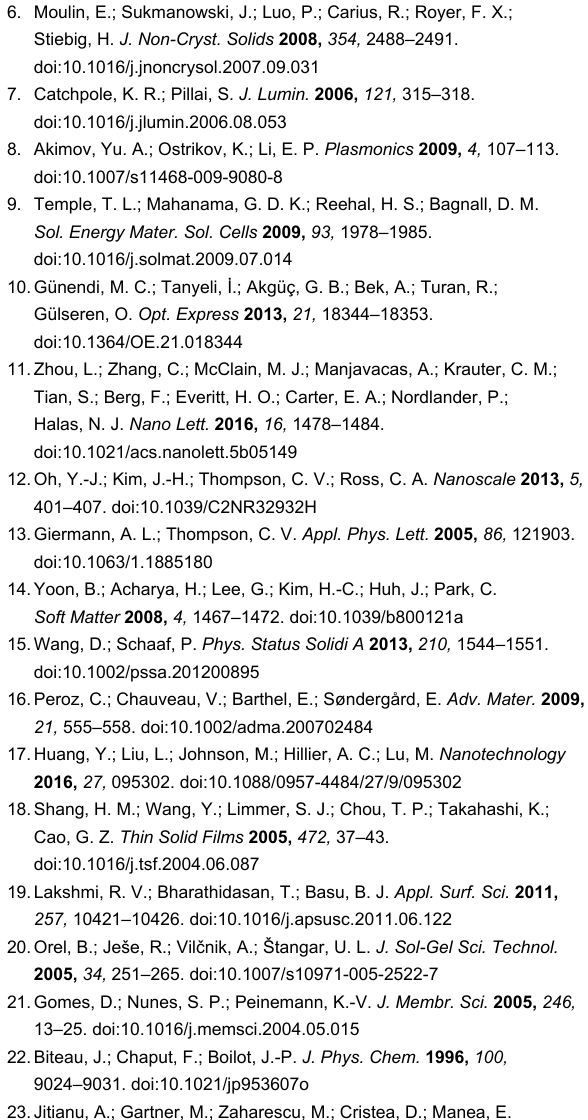
successfully guided the solid-state dewetting process of noble metal films at high temperature without structural degradation. By providing a simple route to assemble nanoparticles on inex- pensive large-area substrates, the method presented here can extend the applications of metal nanoparticles for several optical